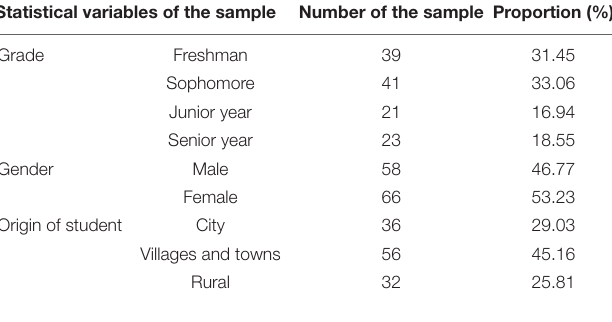
TABLE 1 | Basic information of the research subject. Statistical variables of the sample Number of the sample Proportion (%)